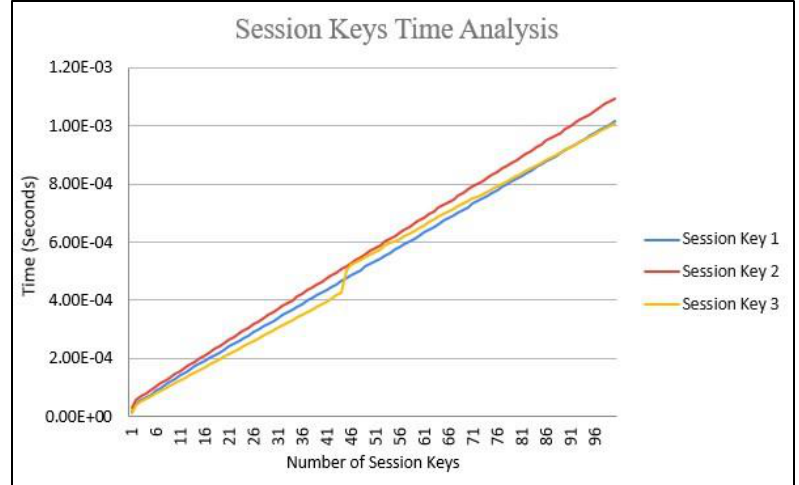
Figure 4. Initial session key time analysis.